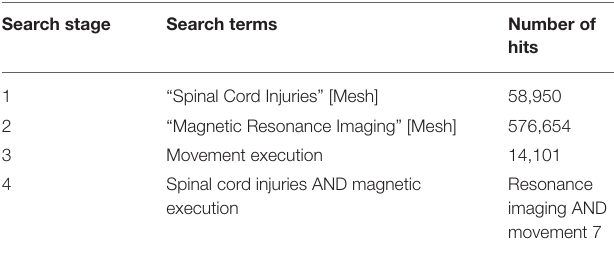
TABLE 3 | Example of keyword search methodology used to identify studies for